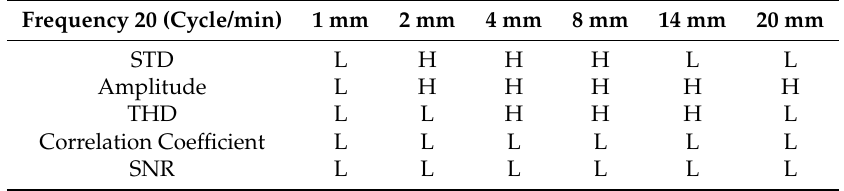
Table A4. Values higher and lower than the median Frequency 20 cycles/min for a 2 mm band.